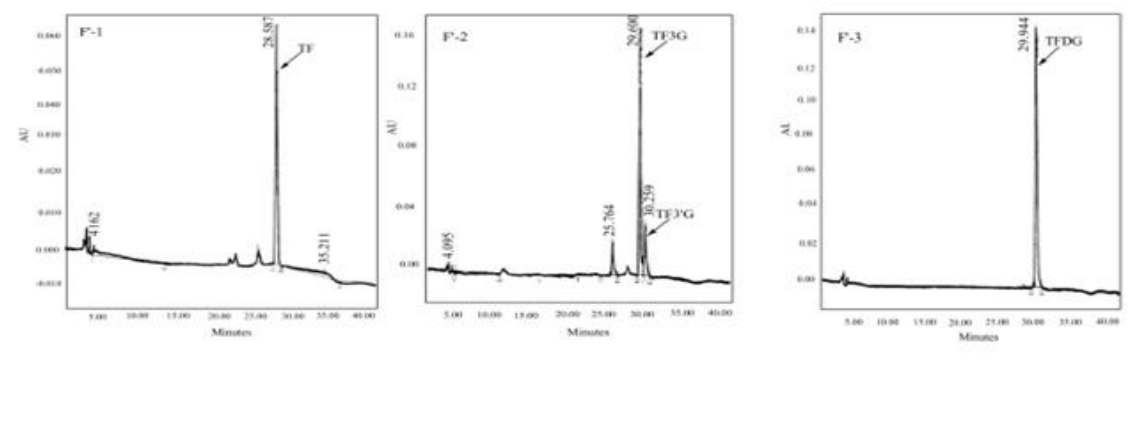
Figure 4. HPLC traces of fractions F’- 1, F’-2, F’- 3 after HSCCC separation- using the solvent system C